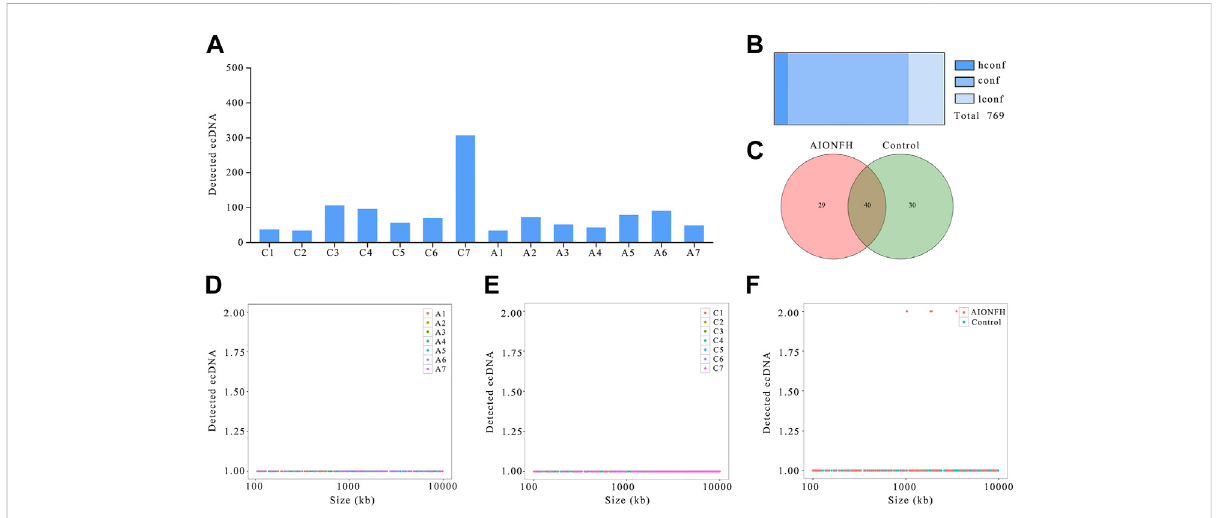
FIGURE 2 EcDNAs number, sizes distribution of AIONFH group and control group. (A) . The total amount of ecDNAs detected in each sample. (B) . Con fi dence of identi fi ed ecDNAs. (C) . Venn diagram showed the consist ecDNAs detected in AIONFH and control samples. (D – F) . The length distribution of ecDNAs (100kb – 10000 kb) in each